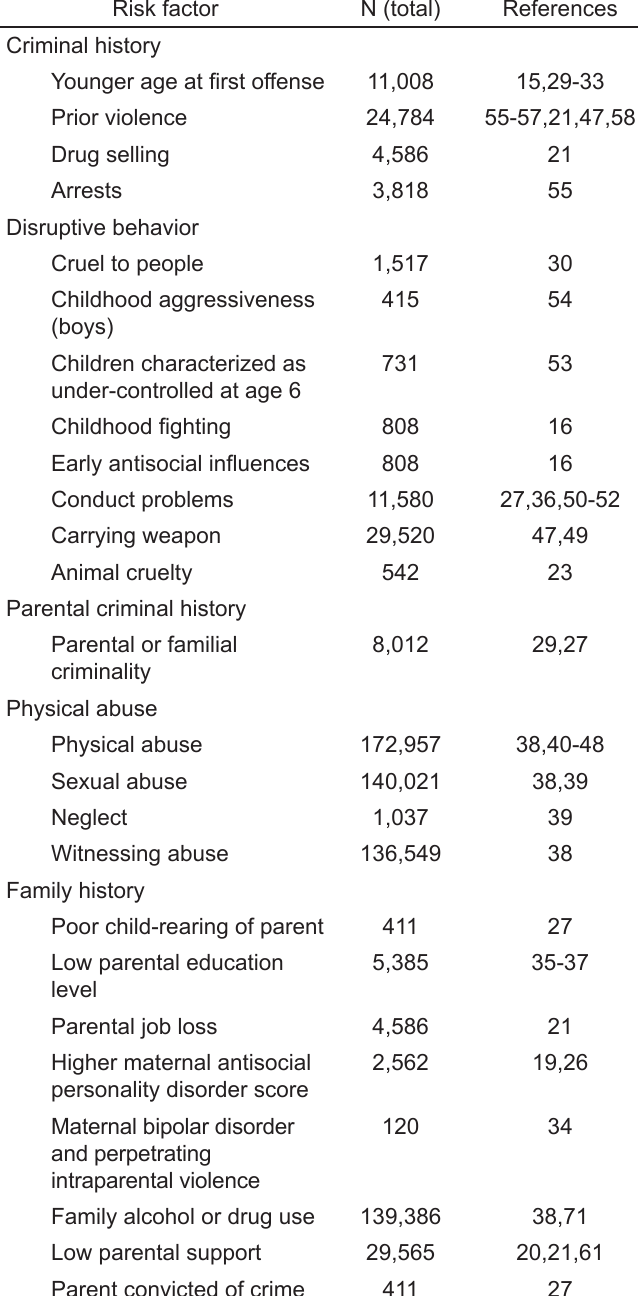
Table 2. Historical risk